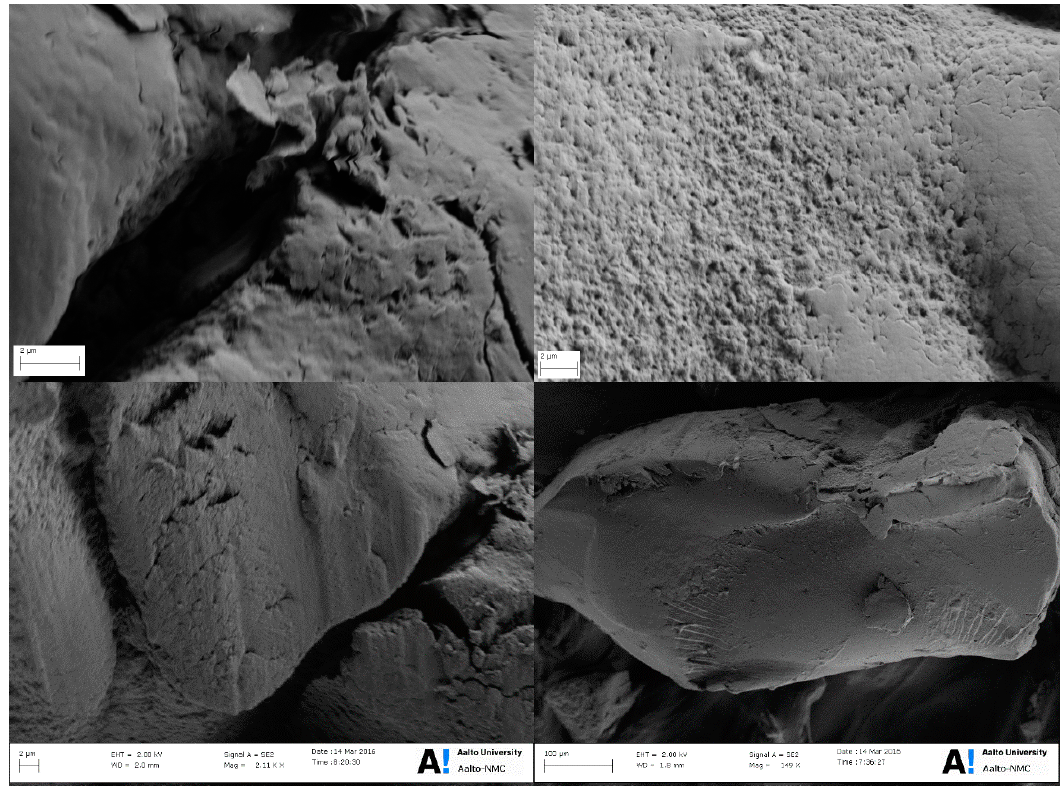
Figure 2. Scanning electron microscopy (SEM) images of Zn(II)–CTS beads at different magnifications (2 μ m and 100 μ